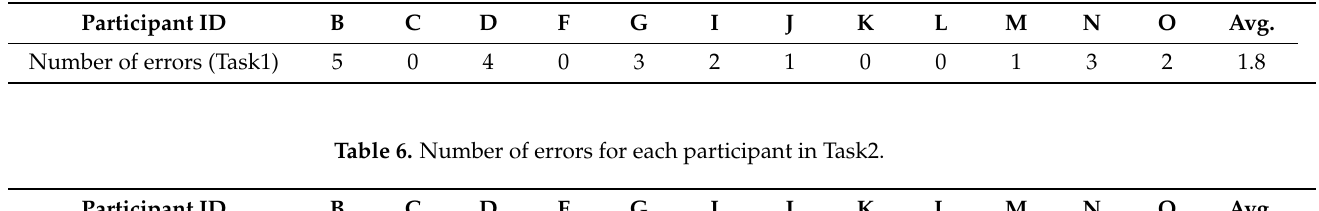
Table 5. Number of errors for each participant in Task1.